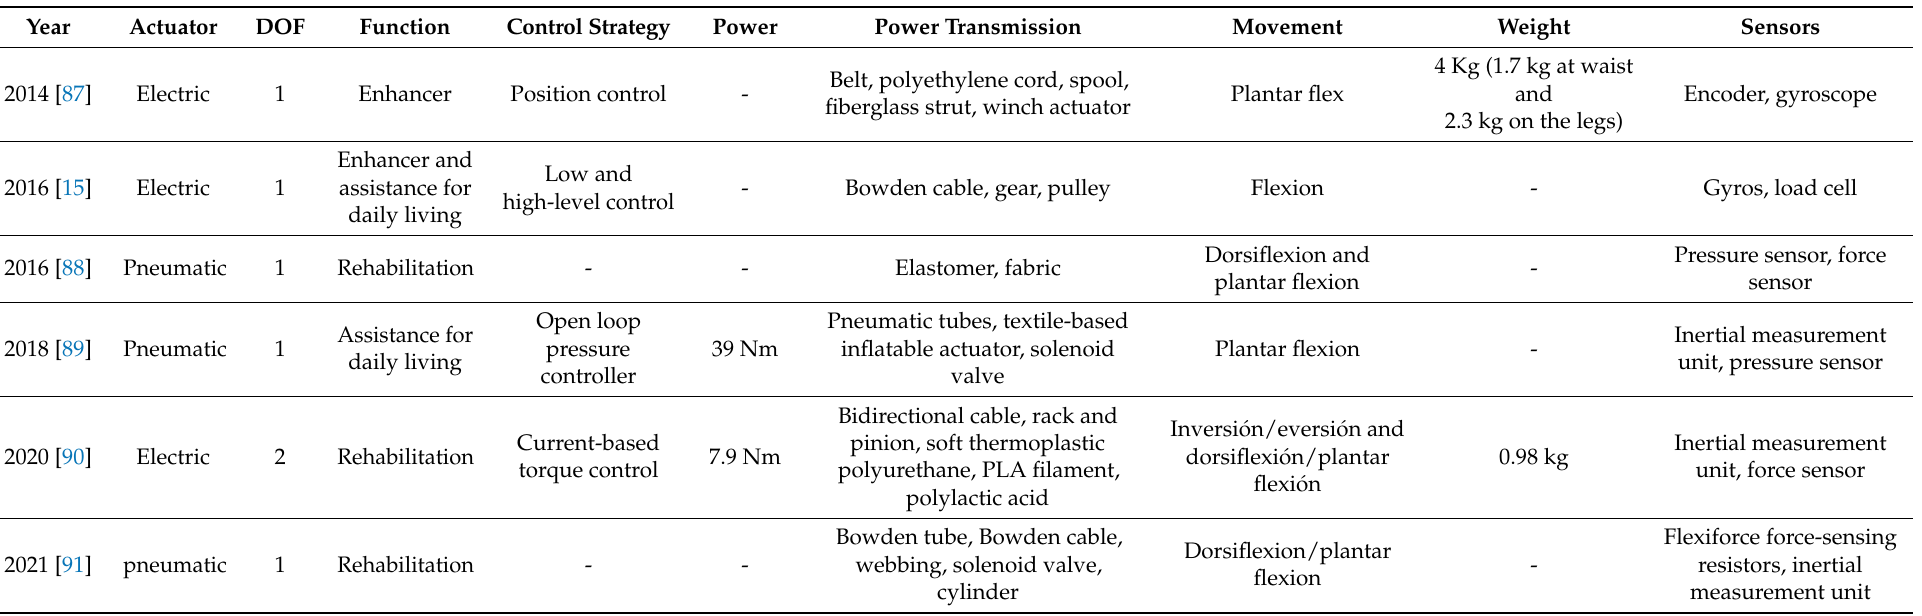
Table 7. Development of soft exoskeletons for the